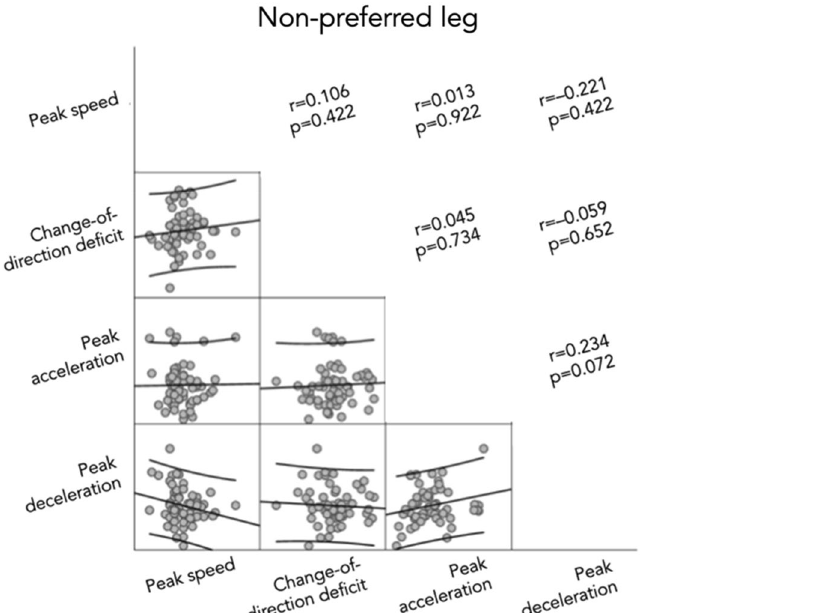
Figure 4. Correlation matrix between measures for non-preferred